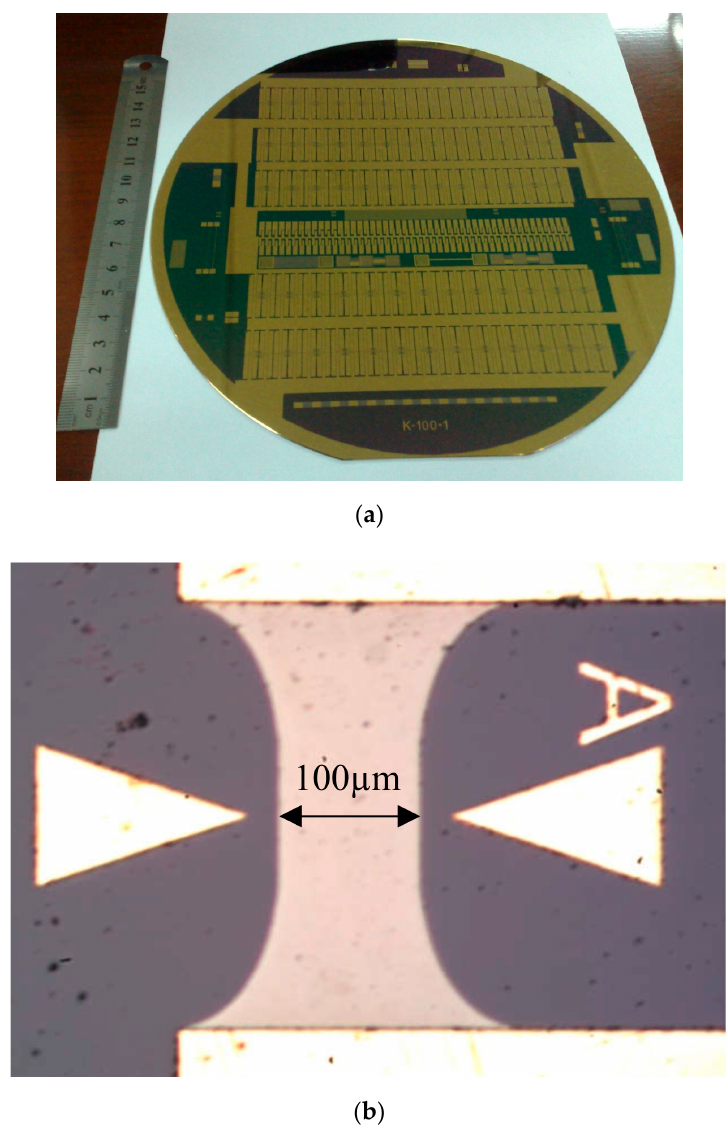
Figure 4. ( a ) Test 8'' Wafer, ( b ) A2 resistor.